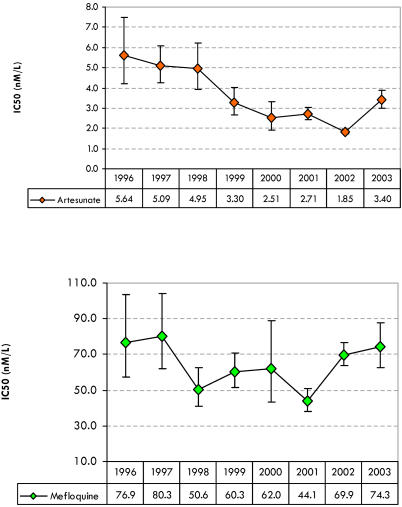
Changes in Drug Sensitivity of P. falciparum IsolatesIsolates from primary infections were collected at SMRU clinics between 1996 and 2003 and assayed for sensitivity to artesunate and mefloquine, IC50 geometric means given as nM/l (95% CI).